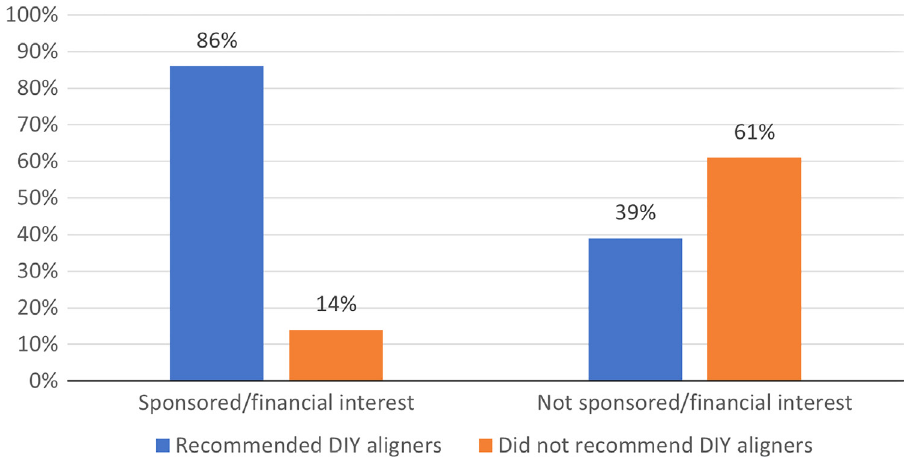
Figure 1. Sponsorship/financial interest vs. author recommendation.